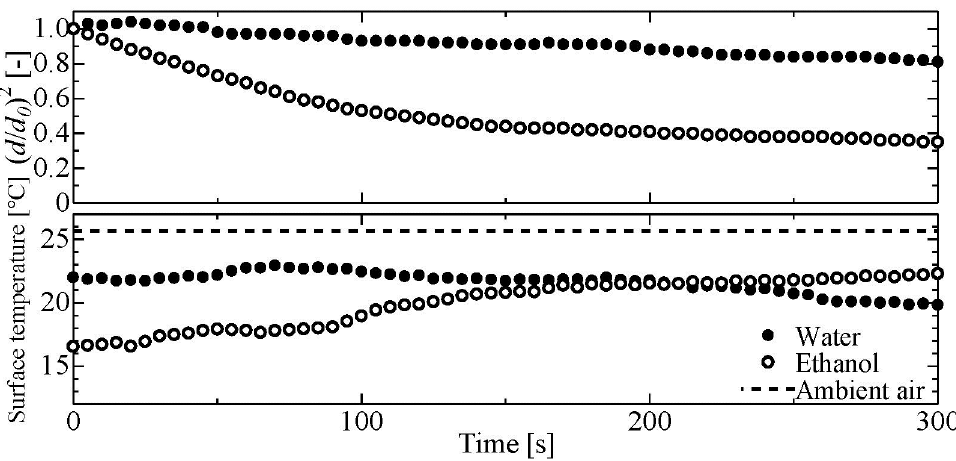
Fig 4. Surface temperature of water and ethanol droplets as a function of